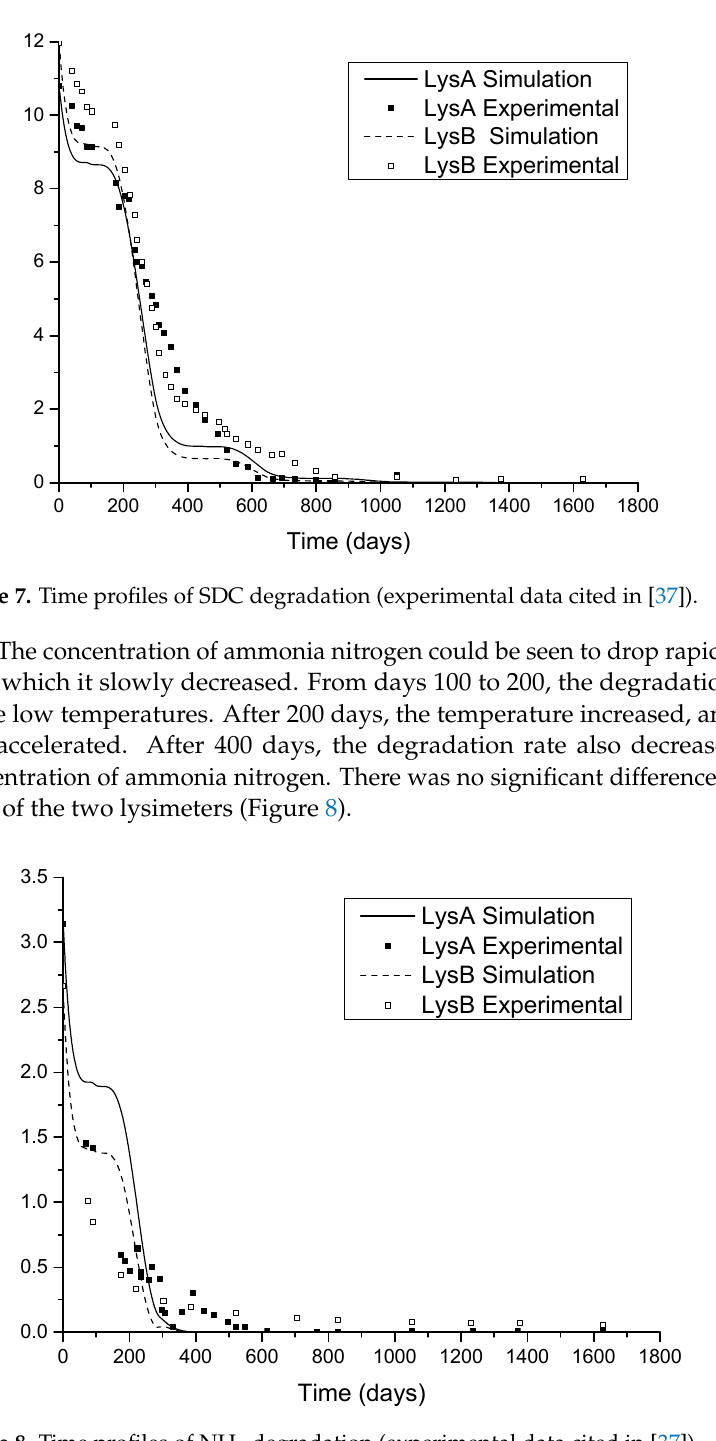
Figure 8. Time profiles of NH 3 degradation (experimental data cited in [37]).